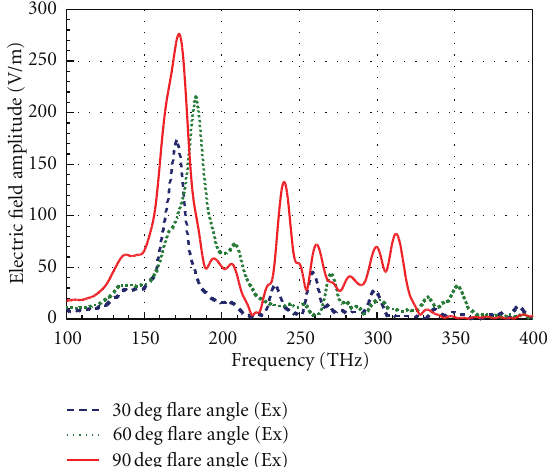
Figure 5: Electric field at the feed gap of bowtie with (a) 30 ◦ , (b) 60 ◦ , and (c) 90 ◦ flare angles due to x -polarized unity strength plane wave incidence.